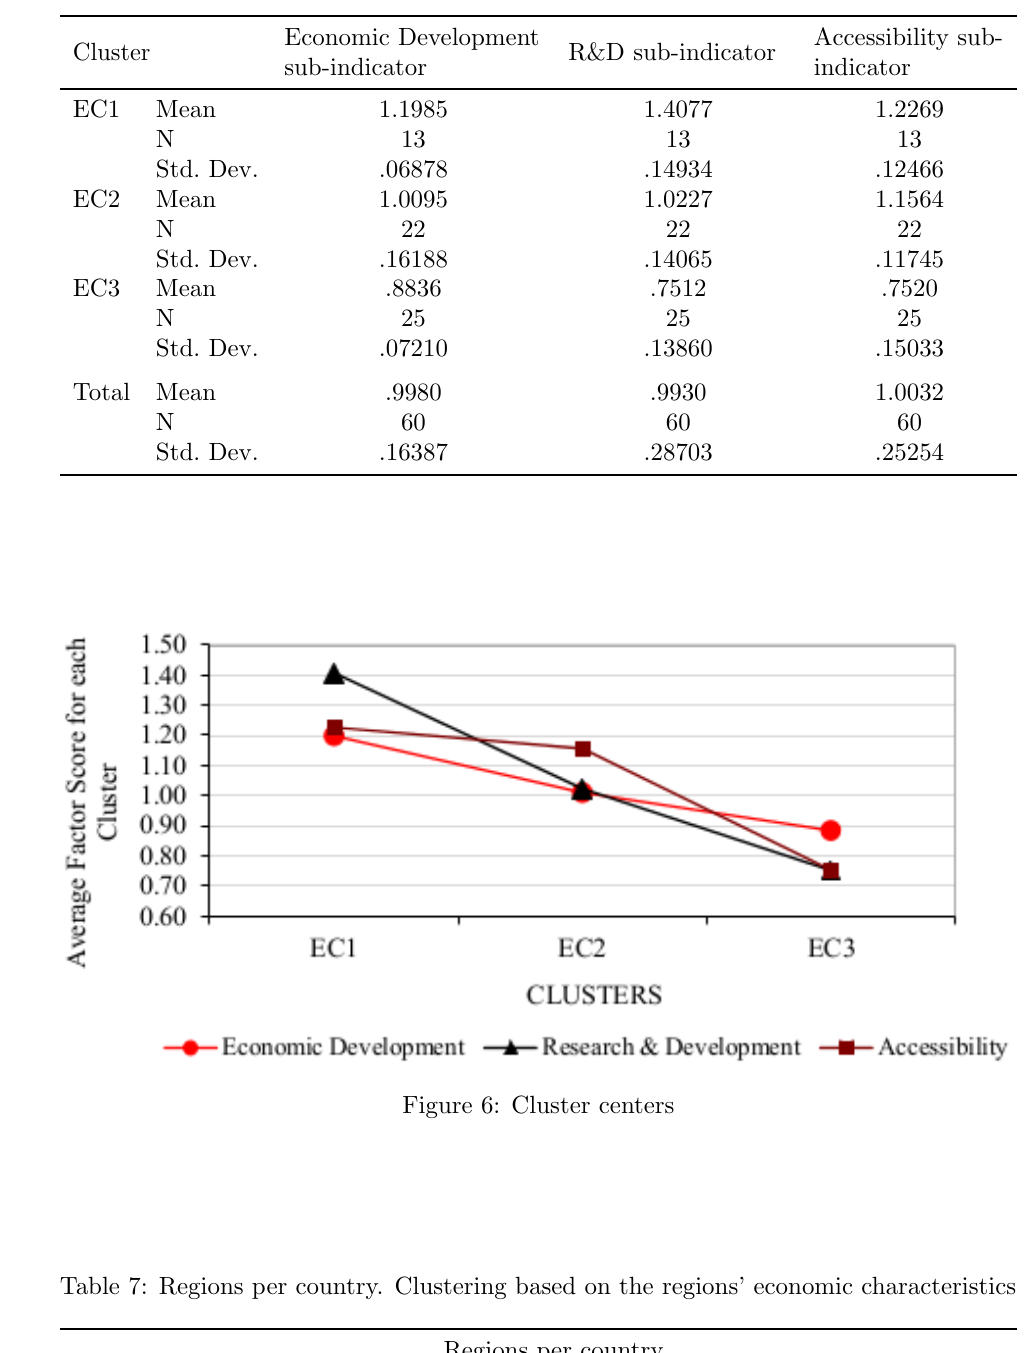
Table 6: Summary Report of the clustering based on the regions’ economic characteristics